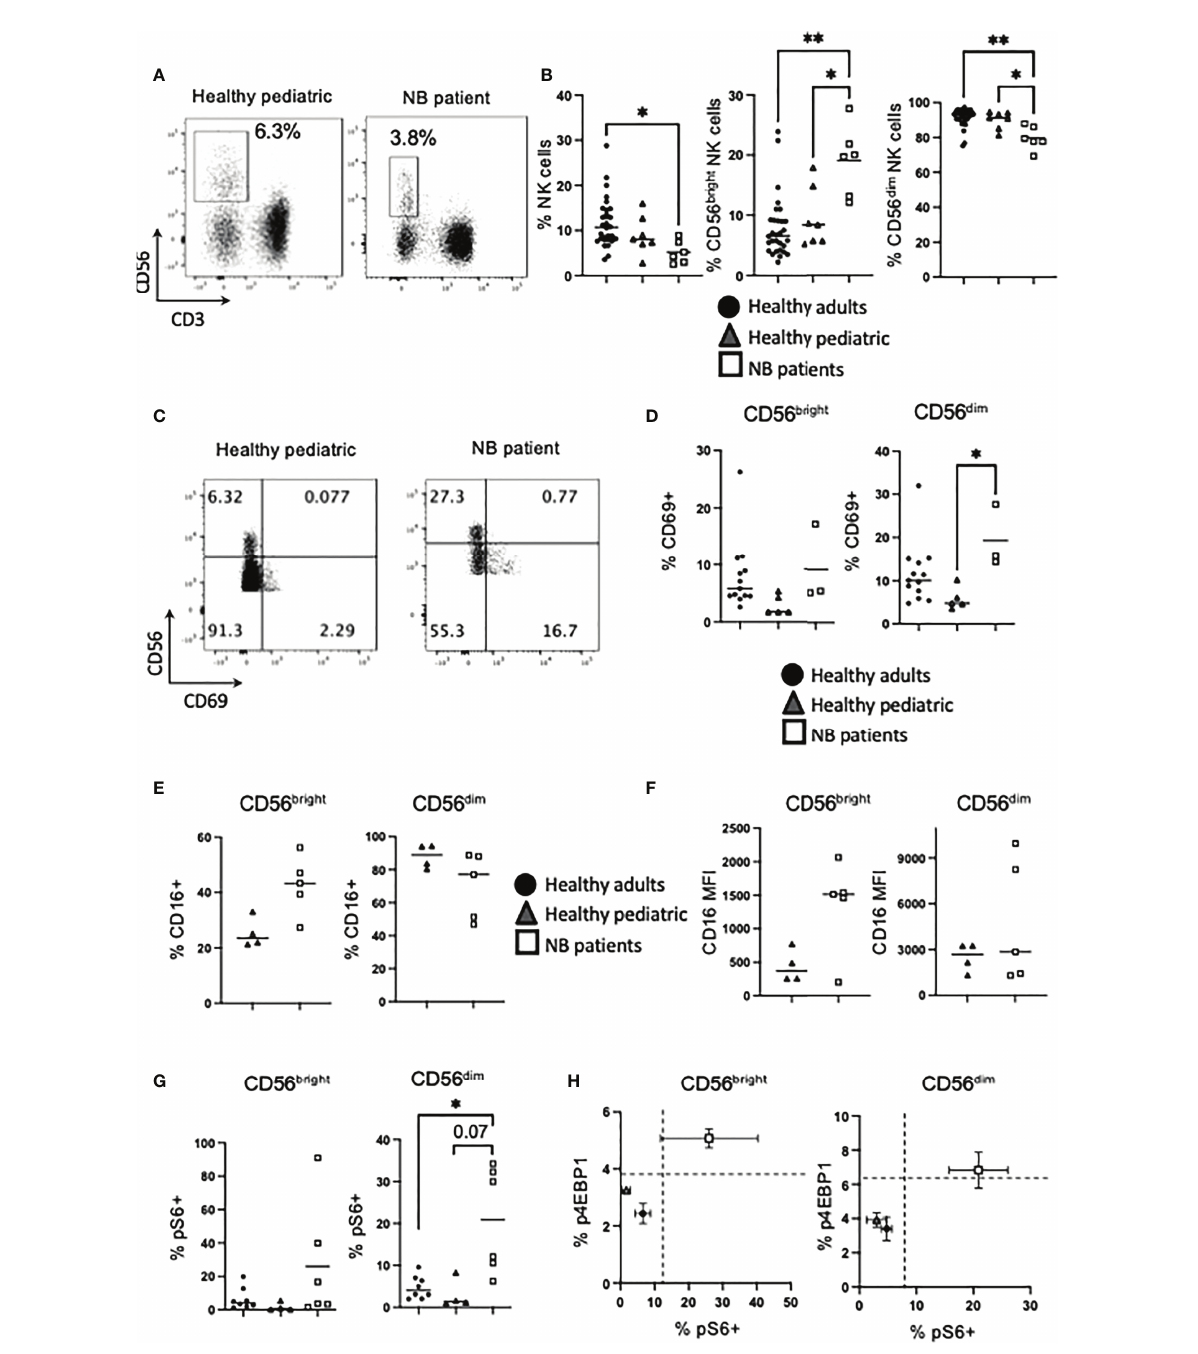
FIGURE 1 NK cells from NB patients are activated and express high levels of CD16. PBMC were isolated from fresh blood of healthy adult donors, healthy pediatric donors and NB patients. (A, B) PBMC were stained for CD56 and CD3 directly ex vivo and analyzed by fl ow cytometry to identify the frequency of NK cells (CD56+ CD3 − ) and the CD56 bright and CD56 dim subsets. (C – H) PBMC were stained for CD69, CD16 and pS6 analyzed by fl ow cytometry. Dots represent individual donors and horizontal bars show the mean. (H) Dots represent the mean and error bars show the SEM. N=3 – 40. Samples were compared using the Two-way ANOVA test or Student ’ s t-test, *p<0.05,